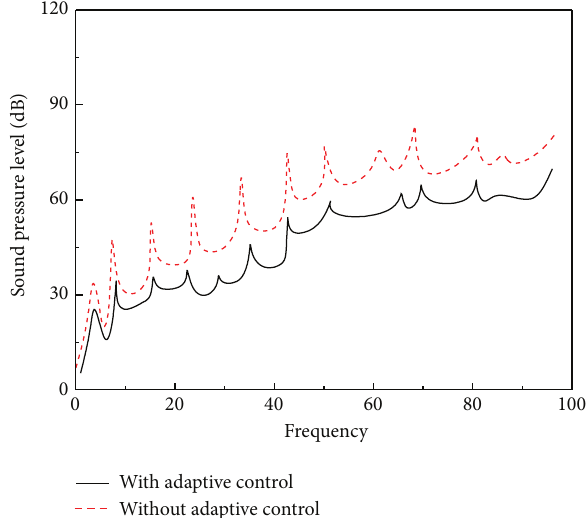
Figure 22: Acoustic response of underwater structure under adap- tive control.